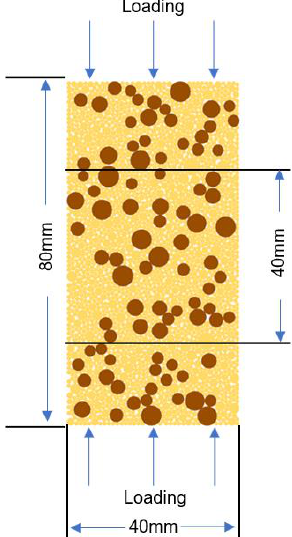
Figure 1. Two-dimensional representation of cold crushing test simulations [23].